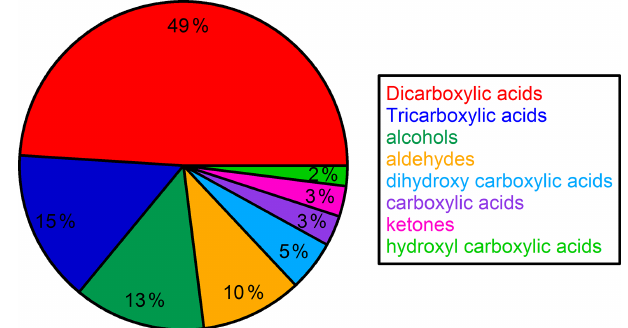
Figure 12. Campaign-averaged relative composition of the sum of all compounds measured by TD–GC–MS in the organic aerosol phase (hydroxyl-carboxylic acid: light-green area; ketone: pink area; carboxylic acid: purple area; dihydroxy carboxylic acid: light- blue area; aldehyde: orange area; alcohol: dark-green area; tricar- boxylic acid: dark-blue area; dicarboxylic acid: red area).